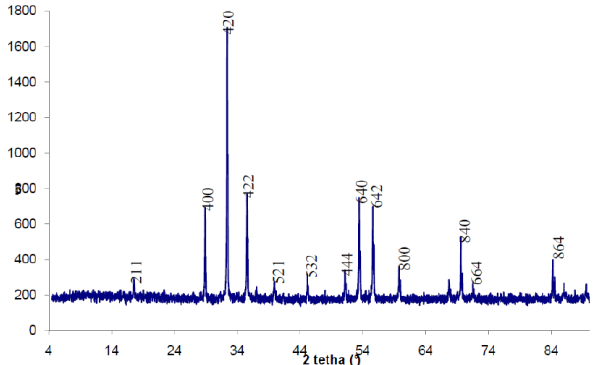
Figure 6: X-ray diffraction pattern for a thick layer obtained by micromachining